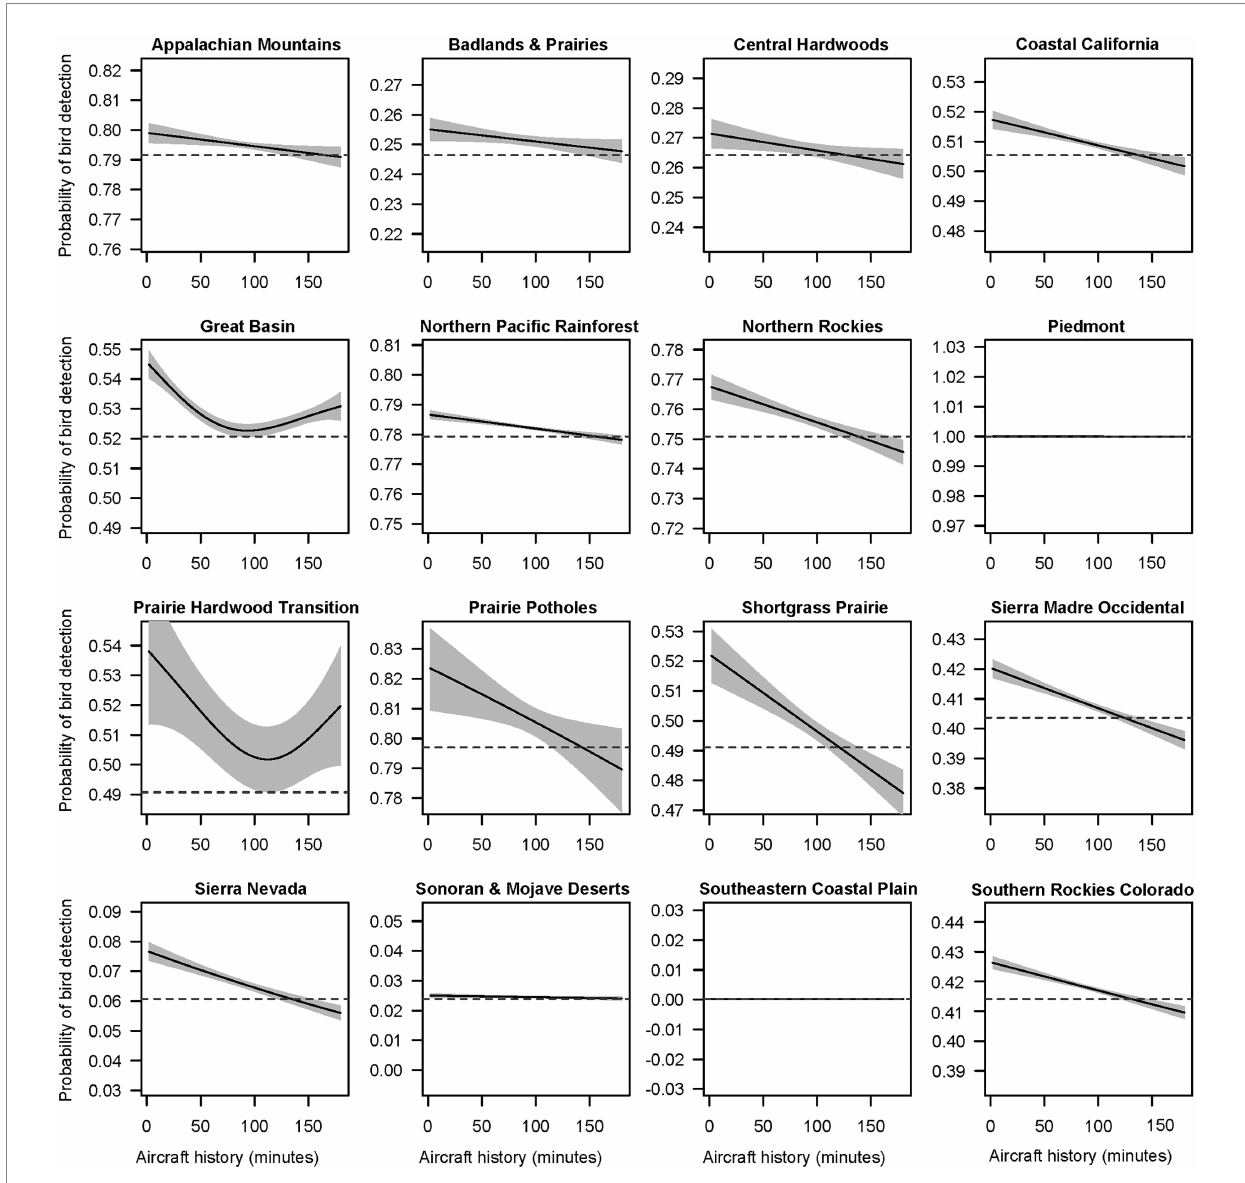
FIGURE 5 Smoothing spline functions for the effect of aircraft noise history on bird detection probabilities in Bird Conservation Regions (BCR). The panels were produced by fitting separate models to a subset of audio survey data from each BCR. Not all BCRs are represented above as aircraft noise was removed by model selection in Boreal Hardwood Transition, Central Mixed Grass Prairie, and Eastern Tallgrass